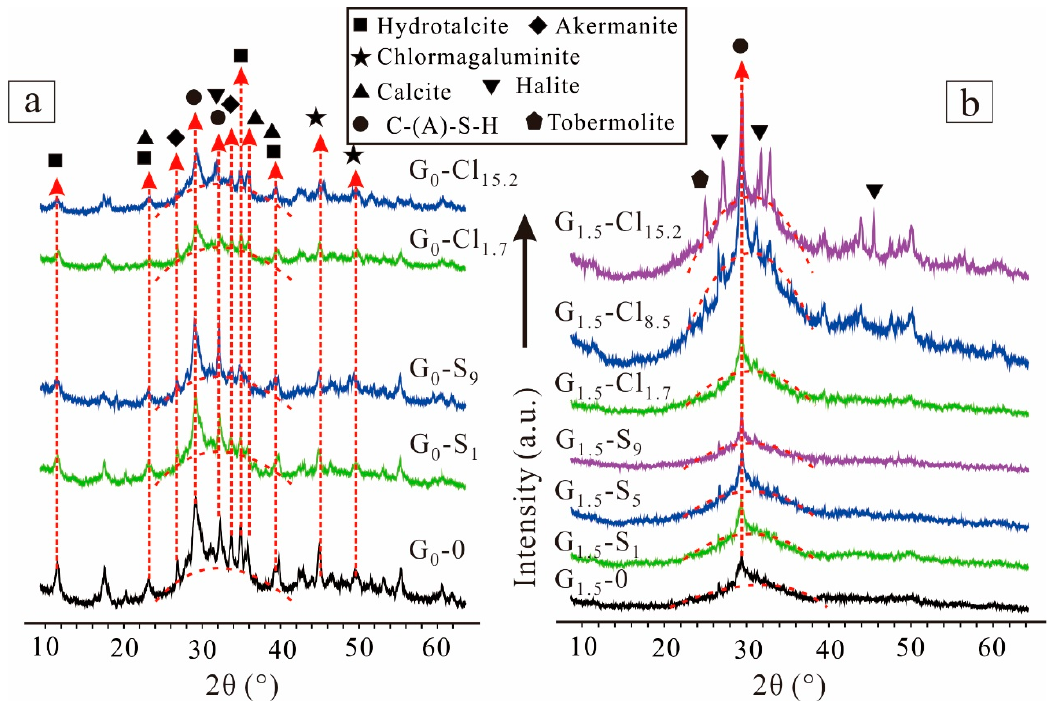
Figure 5. XRD patterns of ( a ) NaOH-activated and ( b ) Na 2 SiO 3 -activated geopolymers.